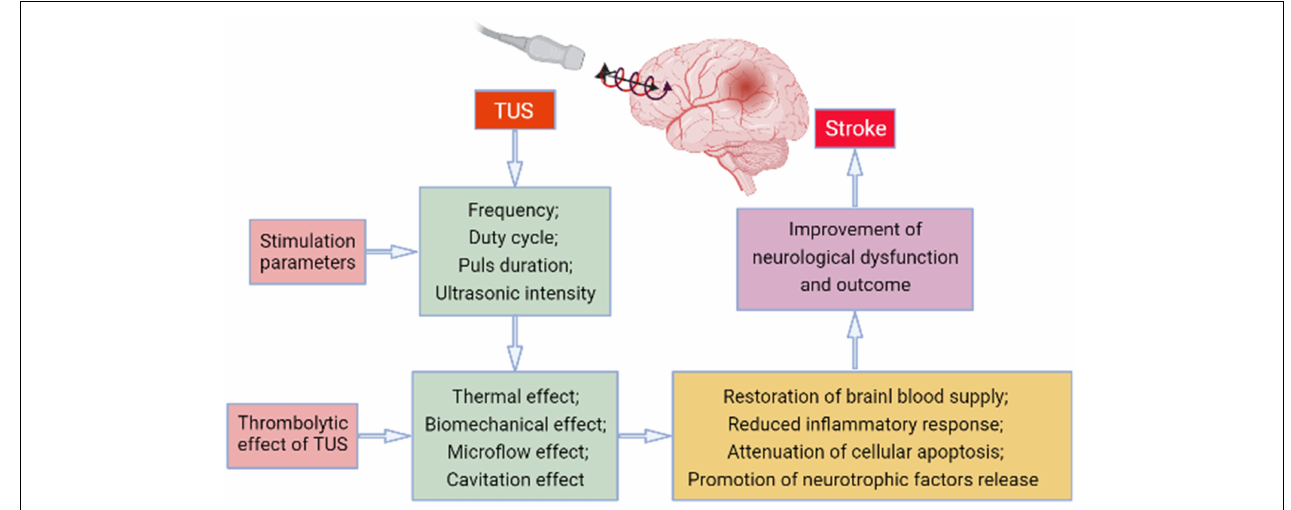
FIGURE 1 | The potential mechanism involved in the transcranial ultrasound stimulation (TUS)-induced effect on